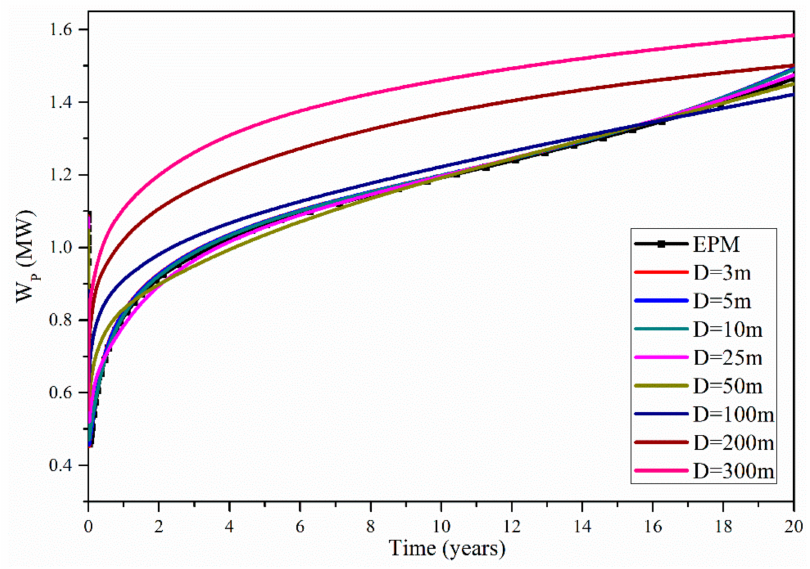
Figure 8. Evolution of the pump power of the EPM method and the MINC